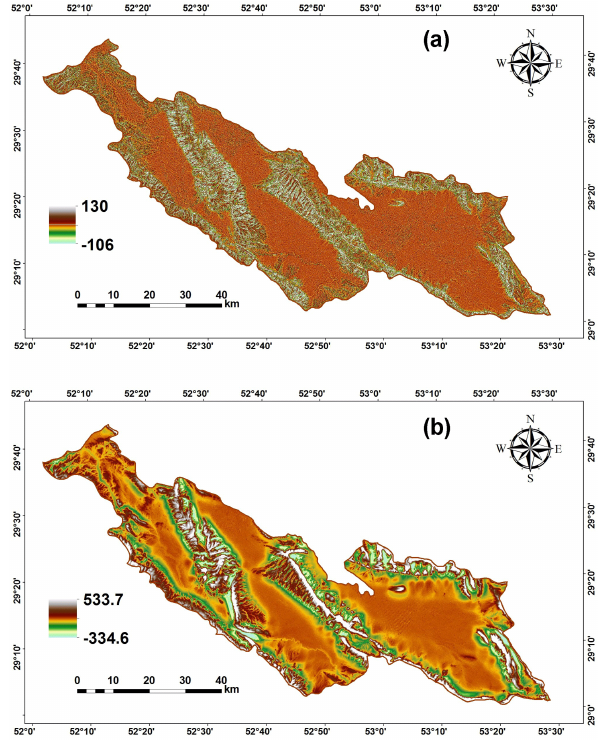
Figure 7. TPI maps generated using (a) small (3 cells) and (b) large (45 cells) neighbourhood.